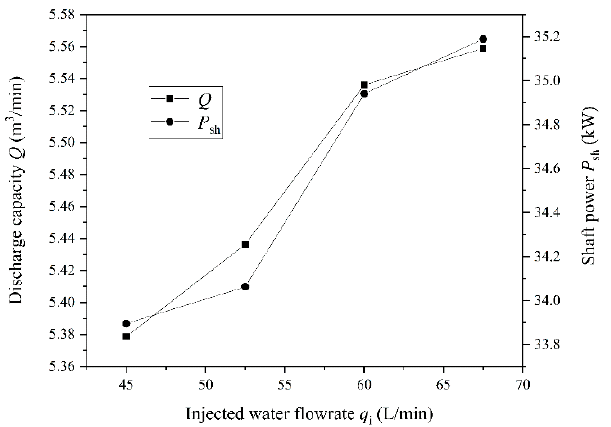
Figure 12. Compressor performance under different injected water flowrates.